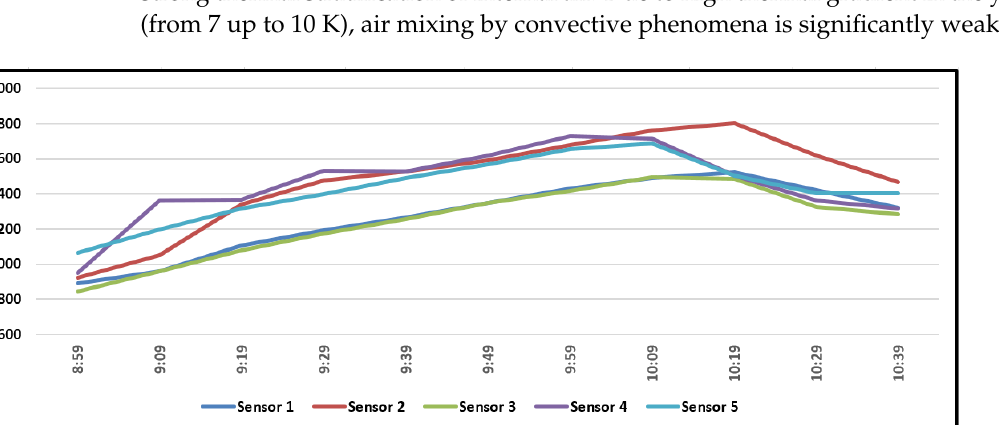
Figure 7. Average CO 2 concentration in the yurt between 14 January and 11 February 2021.